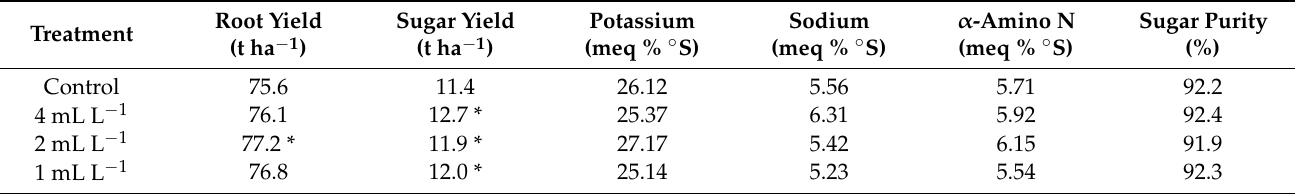
Table 2. Mean values of sugar yield, root yield, and processing quality traits in the BSE-treated and untreated sugar beet. The results are expressed as the mean of four randomized replicates with 60 plants each. ANOVA was used to evaluate the differences between the treatments with a 0.05 p -value threshold. Mean values followed by asterisk differ significantly from the untreated samples.